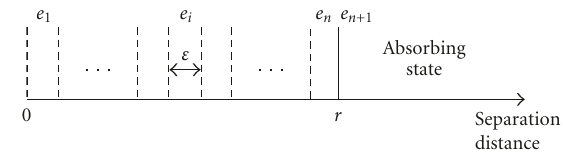
Figure 3: State space for distance between a pair of nodes in the persistent metric group, where separations greater than the trans- mission range (absorbing state) result in a link being